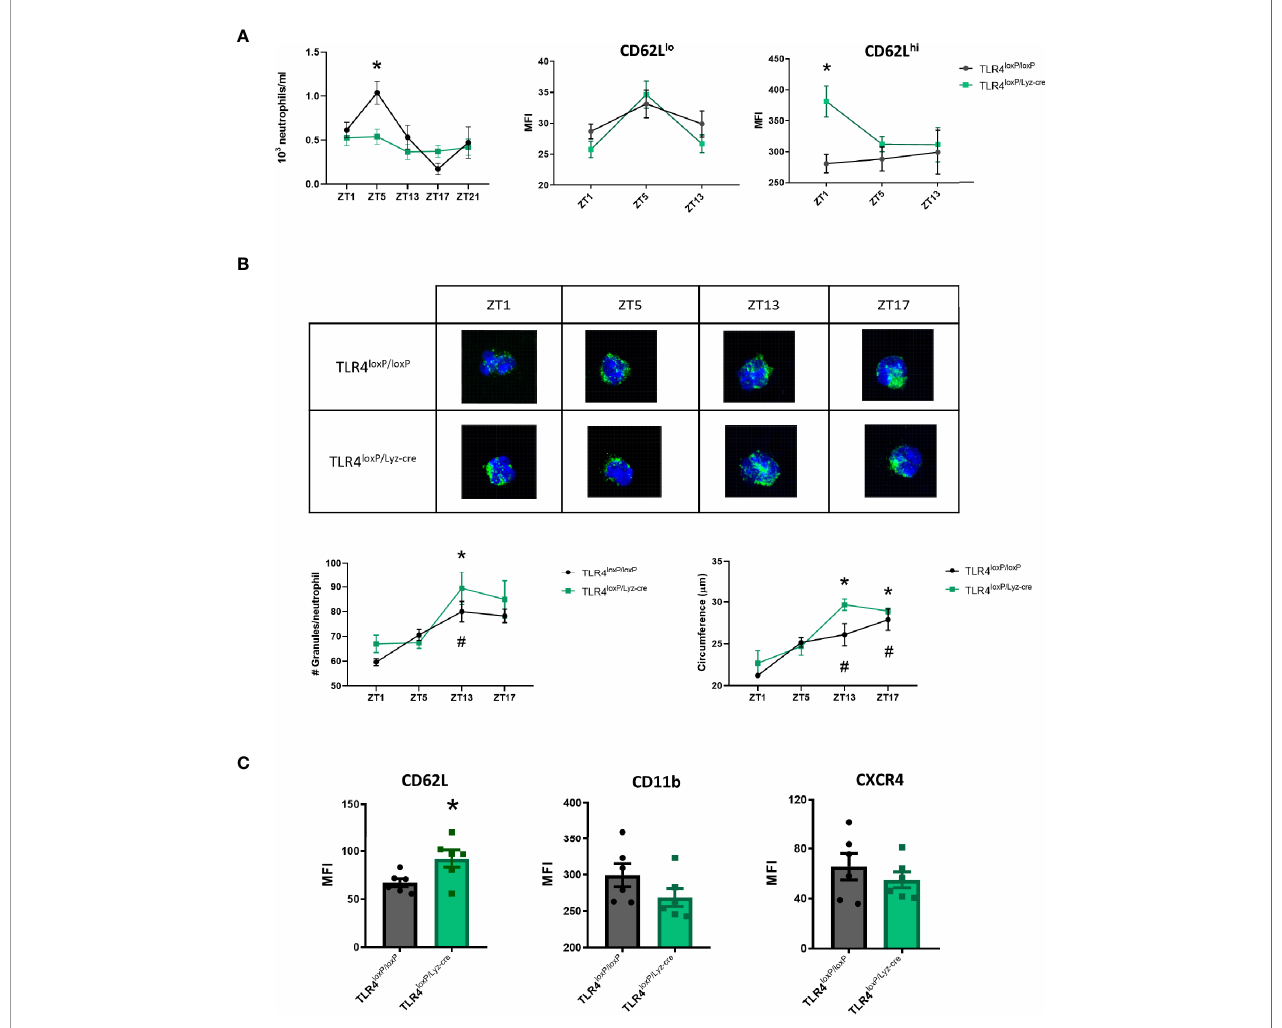
FIGURE 1 | Characterization of TLR4-de fi cient neutrophil dynamics. (A) Left: Total number of neutrophils in blood at ZT1, ZT5, ZT13, ZT17, ZT21 in TLR4 loxP/loxP mice and TLR4 loxP/Lyz-cre mice. Two-way ANOVA analysis showed a signi fi cative difference in the variable time between genotypes (P<0.05, F[4, 30]=4.681, n=3-6). Bonferroni post-hoc analysis showed that at ZT5 there were less neutrophils in blood in TLR4 loxP/Lyz-cre mice than in TLR4 loxP/loxP mice (*P < 0.05 vs TLR4 loxP/loxP ). Middle and right: CD62L expression in neutrophils through time. CD62L MFI (mean fl uorescence intensity) in CD62L lo neutrophils and CD62L hi neutrophils (P < 0.05, n=6). Two-way ANOVA analysis showed a trend to the difference in the genotype variable (P=0.07, F[1, 10]=4.016, n=6). Bonferroni post-hoc analysis showed a signi fi cative higher expression of CD62L at ZT1 (*P < 0.05 vs TLR4 loxP/loxP , n=6). (B) Quanti fi cation of primary granules from confocal images. Representative images of granule content of neutrophils (green: MPO, blue: DAPI). Bottom left: number of granules per neutrophil at different time points (n=3, 15 neutrophils per mouse, *P < 0.05 vs TLR4 loxP/loxP ZT1, # P < 0.05 vs TLR4 loxP/Lyz-cre ZT1). Bottom right: Neutrophil circumference (µm) (n=3, 15 neutrophils per mice, *P < 0.05 vs TLR4